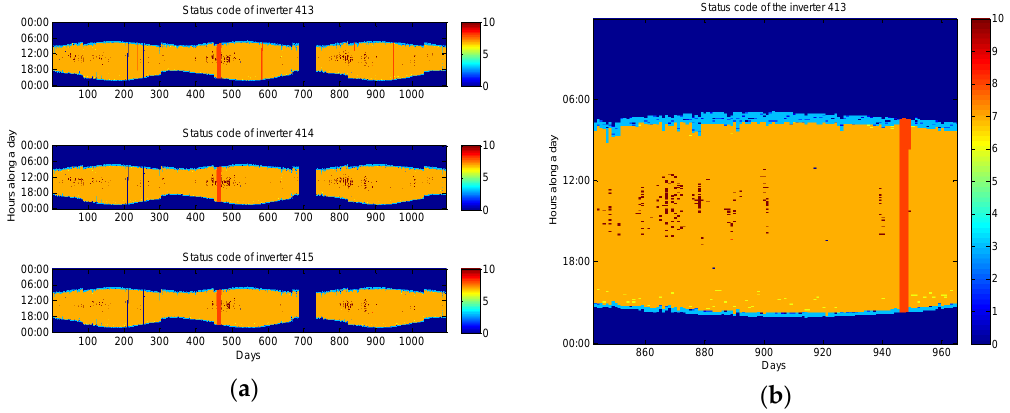
Figure 14. Inverter losses, from 1 January 2011 to 31 December 2013: ( a ) instantaneous values, during 24 h a day; and ( b ) total daily values.